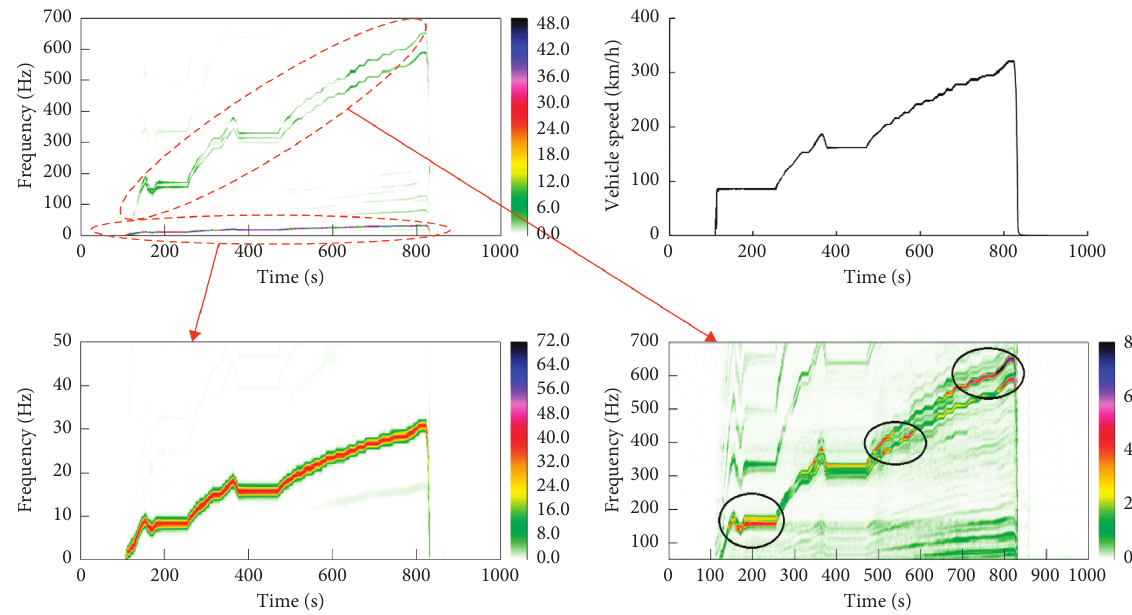
Figure 8: Time-frequency analysis of the axle stress test